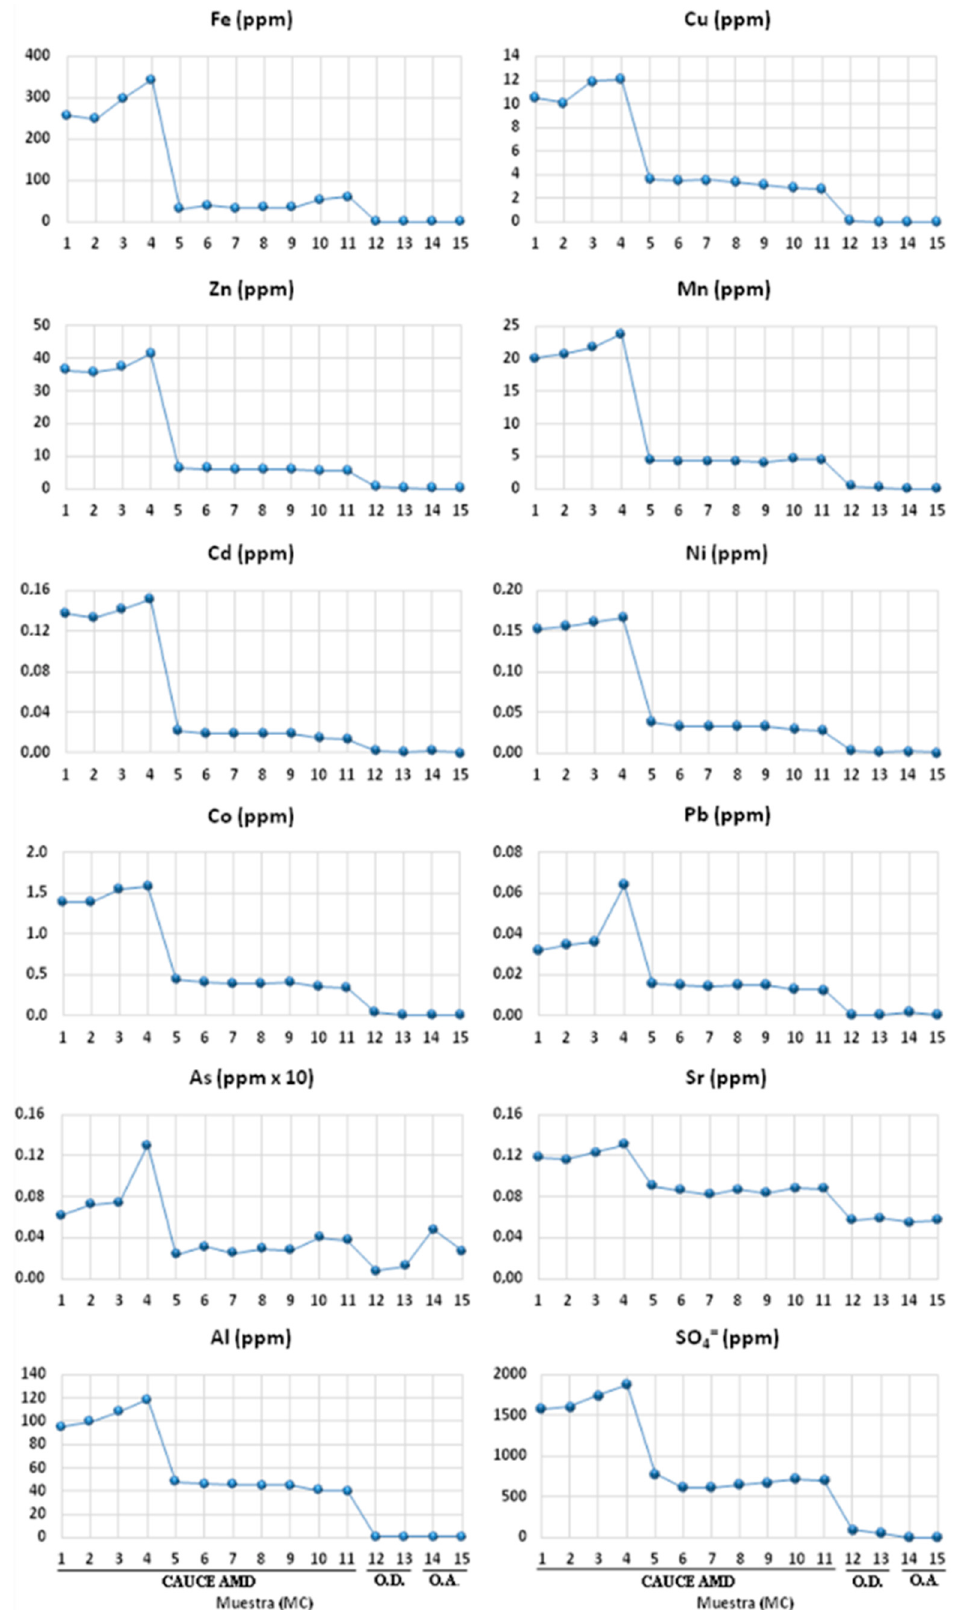
Figure 5. Spatial evolution of the parameters analysed in the laboratory (on the “x” axis the sampling points are represented and on the “y” axis the variables analysed.